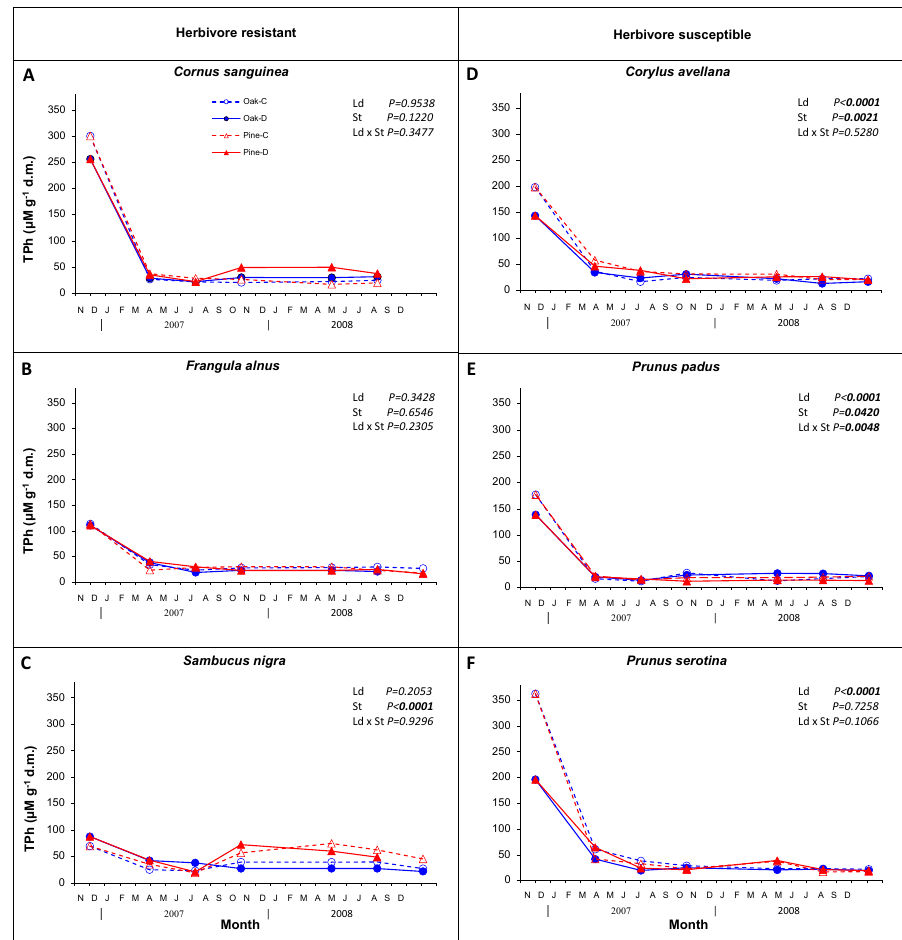
Figure 3. Changes in content of total phenols (TPh; expressed as μ M of chlorogenic acid g -1 d.m.) in leaf litter of six under- story plant species (herbivore resistant species: Cornus sanguinea —( A ), Frangula alnus —( B ), Sambucus nigra —( C ), on the left and herbivore susceptible species: Corylus avellana —( D ), Prunus padus —( E ), Prunus serotina —( F ), on the right), de- pending on leaf damage (Ld; control (C) and damaged (D)) in two stand species (St; oak and pine monocultures). The stand species did not significantly differentiate the content of tannin and TPh in the leaves (Table 2). In all plant species, the levels of these compounds were practically the same under both stand species. The initial content of tested metabolites or N did not affect the decay rate ( k ), which depended primarily on insect susceptibility and understory plant species, and to some extent on the stand species; a significant interaction was noted between susceptibility and stand species (Table 1). The stand species did not affect the differences in average TPh and tannin content between damaged and undamaged leaves determined throughout their decomposition period (Table 2).